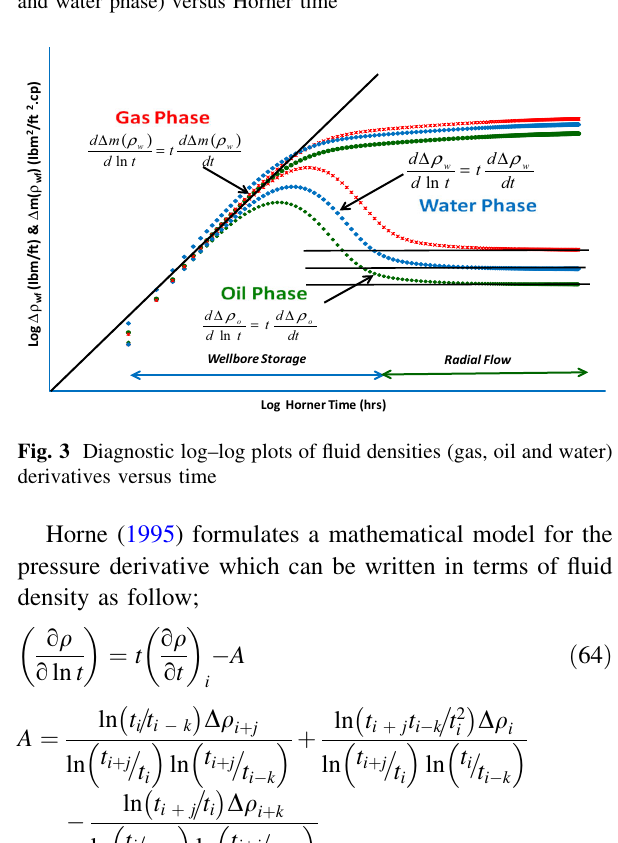
Fig. 2 Specialised diagnostic semi-log plot of fluid densities (gas, oil and water phase) versus Horner time